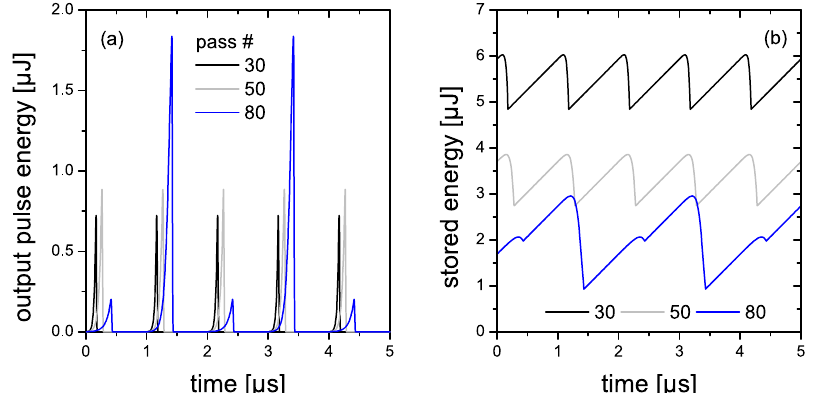
Figure 6. Simulation of the rate equations in the case of Yb:CaF MHz and continuous pumping at 8 W; output pulse energy ( a ) and stored energy within the gain medium ( b ) vs.